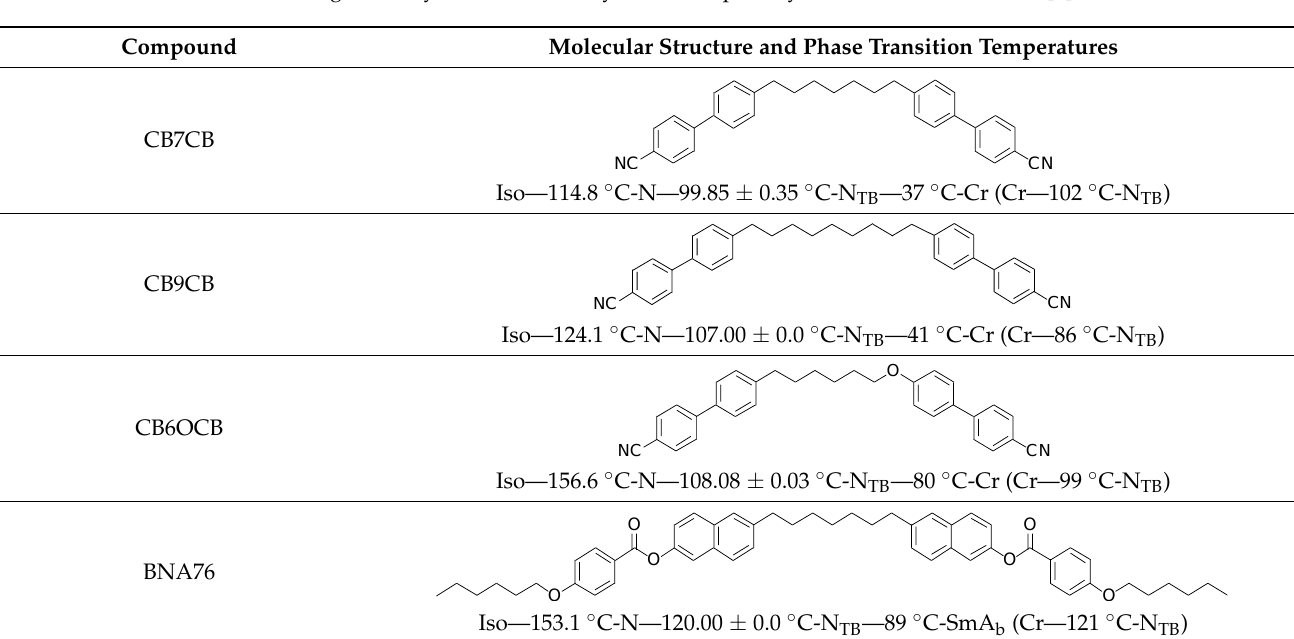
Table 1. Molecular structure and phase transition temperatures of the mesogenic dimers. The temperatures are measured on cooling in our thin sandwich cells. The biphasic coexistence range and its median temperature, T c , are shown for the N-N TB phase transition. Also shown, in brackets, are the melting points of the crystal/solid which gives the N TB phase for the three cyanobiphenyl dimers [15] and that containing two naphthalene groups [39]. These are included to show that thermodynamically the twist-bend nematic range can be extremely short; however this range can be significantly extended as early studies, especially for CB7CB, have shown [7].